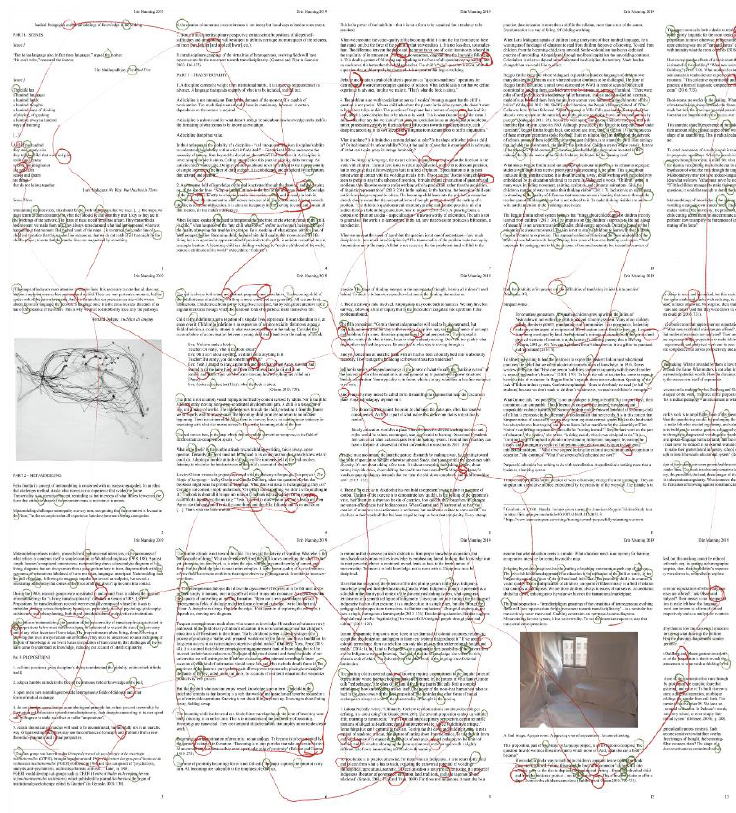
Figure 6 : Conjunctions and definite articles Enabling constraint – linking the